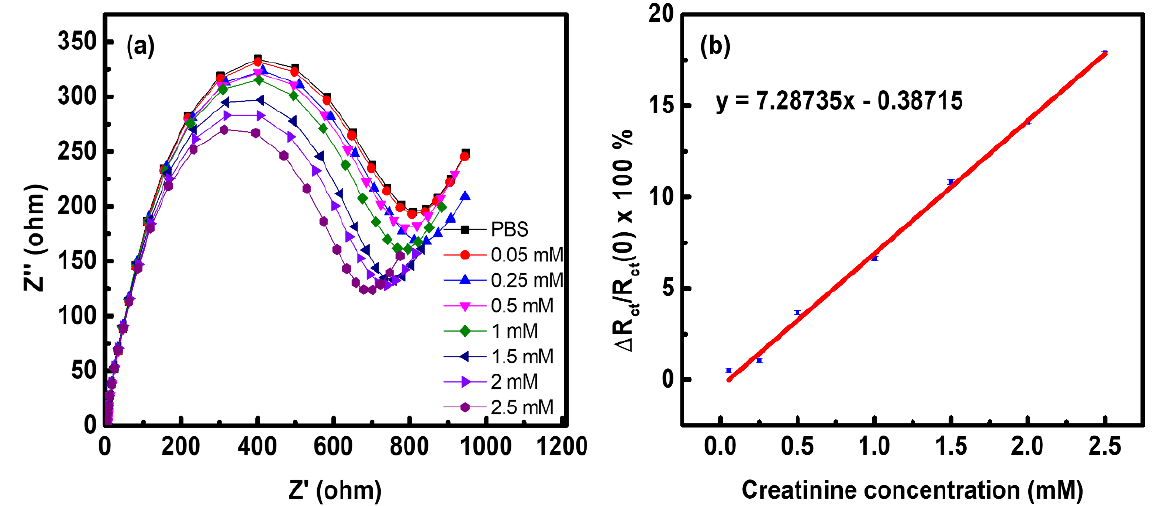
Figure 7. ( a ) EIS curves for ZIF-8 NPs/PEDOT:PSS/ITO electrode in different concentrations of creatinine (0.05 mM to 2.5 mM) ( b ) ( Δ R ct /R ct (0)) × 100% vs. creatinine concentration plot.